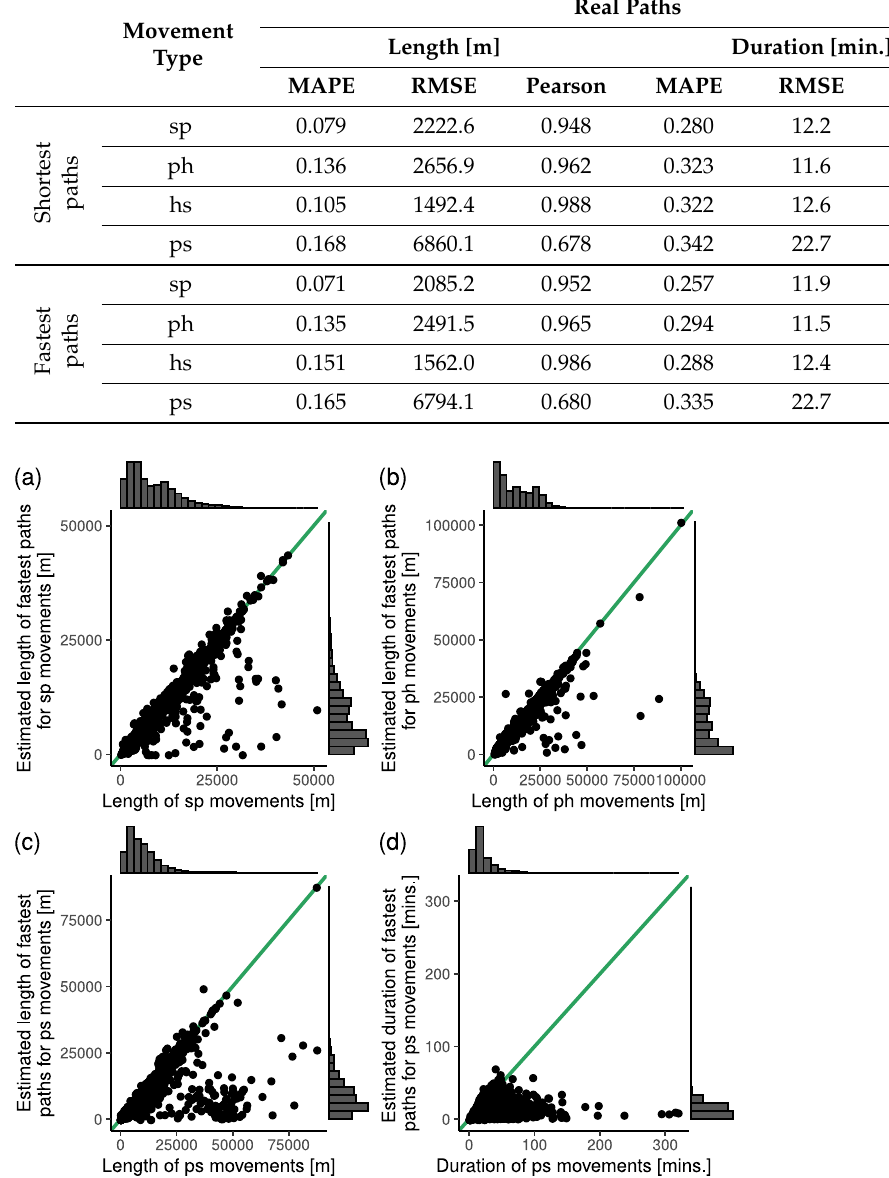
Figure 10. The scatter plots of observed and estimated parameters of movements. ( a ) The lengths of “sp”-type movements. ( b ) The lengths of “ph”-type movements. ( c ) The lengths of “ps”-type movements. ( d ) The duration of “ps”-type movements. To facilitate the comparison, we display a diagonal line with slope 1.0 in each plot, and we show the histogram for each